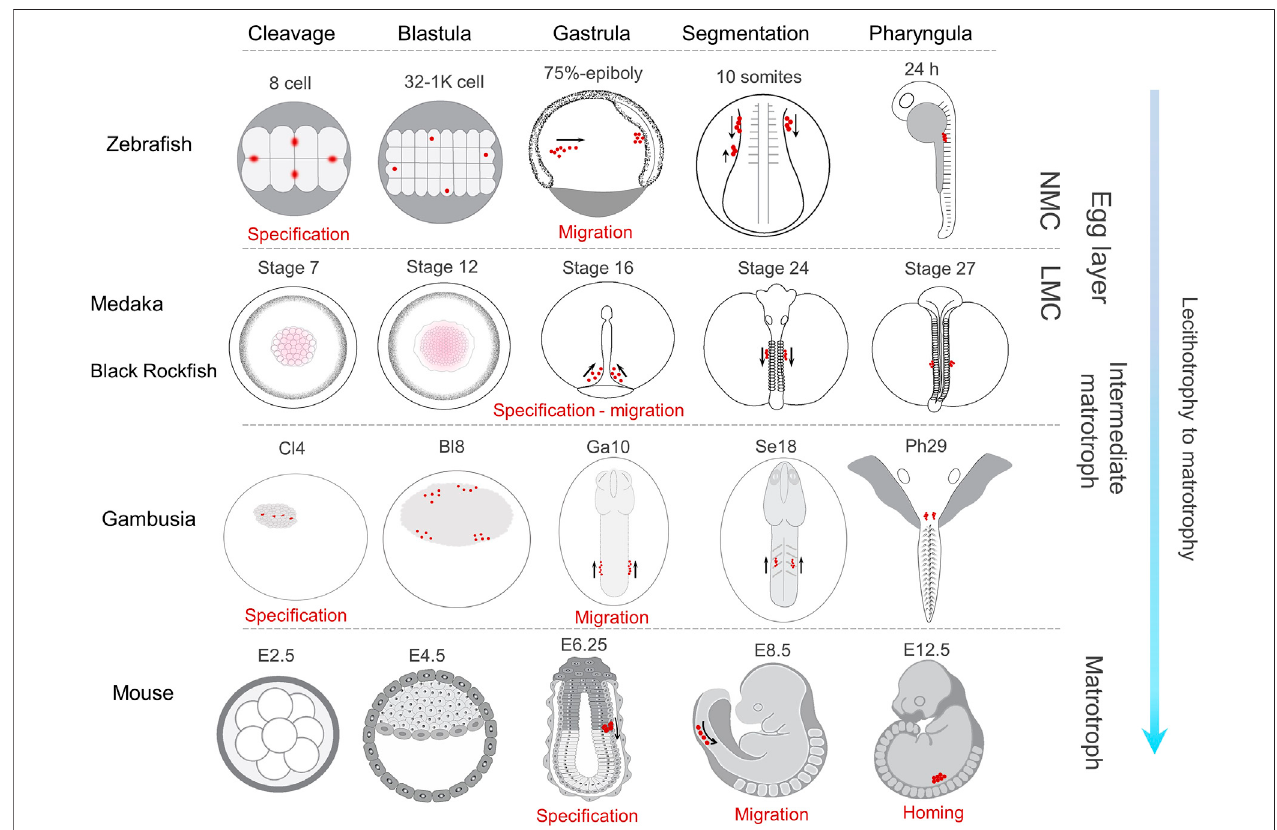
FIGURE 7 | Comparative PGC development in representative lecithotrophic and matrotrophic species with increasing level of maternal care. In zebra fi sh (Raz, 2003; Eno and Pelegri, 2013) and G. holbrooki , PGC markers are compartmentalised in four distinct cells (red dots) by cleavage (8-cell and Cl4, respectively). They later form four clusters in Blastula (32-1K Cell and Bl8 stages, respectively). In gambusia, two each ofthe four clustersmerge at gastrula (Ga10) and appear as a cluster each on either side of the body axis, while in zebra fi sh this rearrangement is postponed to 10 somites. In medaka (Herpin et al., 2007) and black rock fi sh (Zhou et al., 2020), the Gp markers are dispersed throughout the cytoplasm of blastomeres (stages 7 and 12) until gastrula where the nanos -positive cells are evident at stage 16, forming two clusters in either side of the body. In mice, PGC speci fi cation is fi rst evident in egg cylinder stage (E6.25) and the PGCs remain in a single cluster until their colonisation (Saitou and Yamaji, 2010). The onset of PGC migration in all the four species occurs at gastrula, albeit slightly delayed in mice. However, the pattern of their migrationissomewhatdissimilarduetodevelopmentalconstraintsspeci fi ctotherespectivespecies.Inallthefourteleosts,duringsegmentation,PGCclusterscoalesce in either side of the body axis and migrate towards PGR. In contrast only one cluster forms in mice, an arrangement persisting until PGC colonisation (at E12.5). The direction of PGC migration at segmentation is predominantly posterior in both zebra fi sh and medaka, while this is anterior in G. holbrooki and mice. NMC, no maternal care; LMC, low maternal